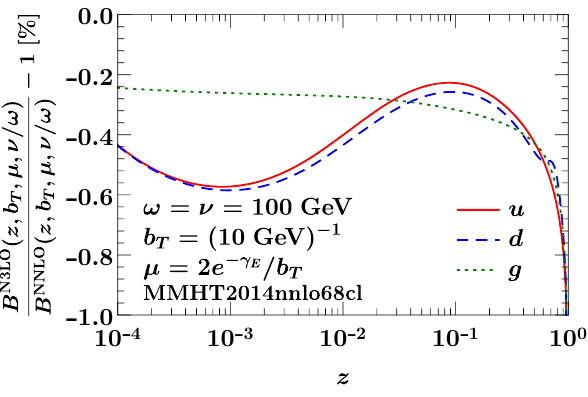
Figure 4 . The K -factor of the N 3 LO beam function, i.e. the ratio of the N 3 LO beam function to NNLO beam function. We (cid:12)x b T = (10 GeV) (cid:0) 1 and ! = 100 GeV and choose the canonical scales (cid:22)b T = 2 e (cid:0) (cid:13) E and (cid:23) = ! , such that the shown beam function corresponds to the boundary term in a resummed prediction. The di(cid:11)erent colors show the results for an u -quark, d -quark and gluon,